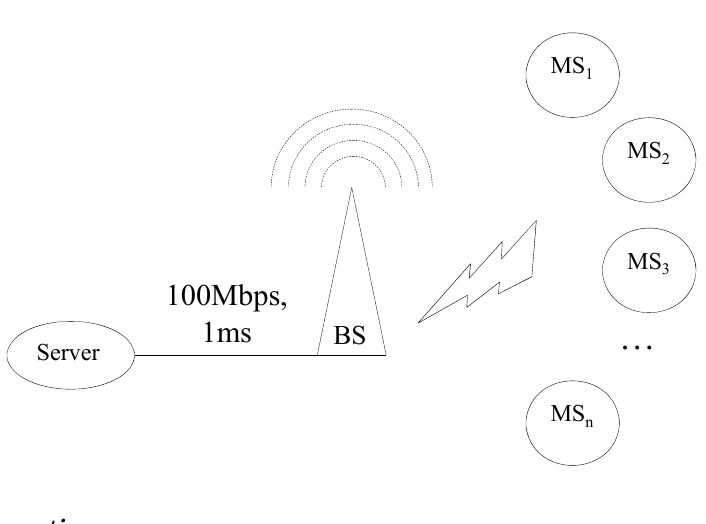
Figure 4. Simulation